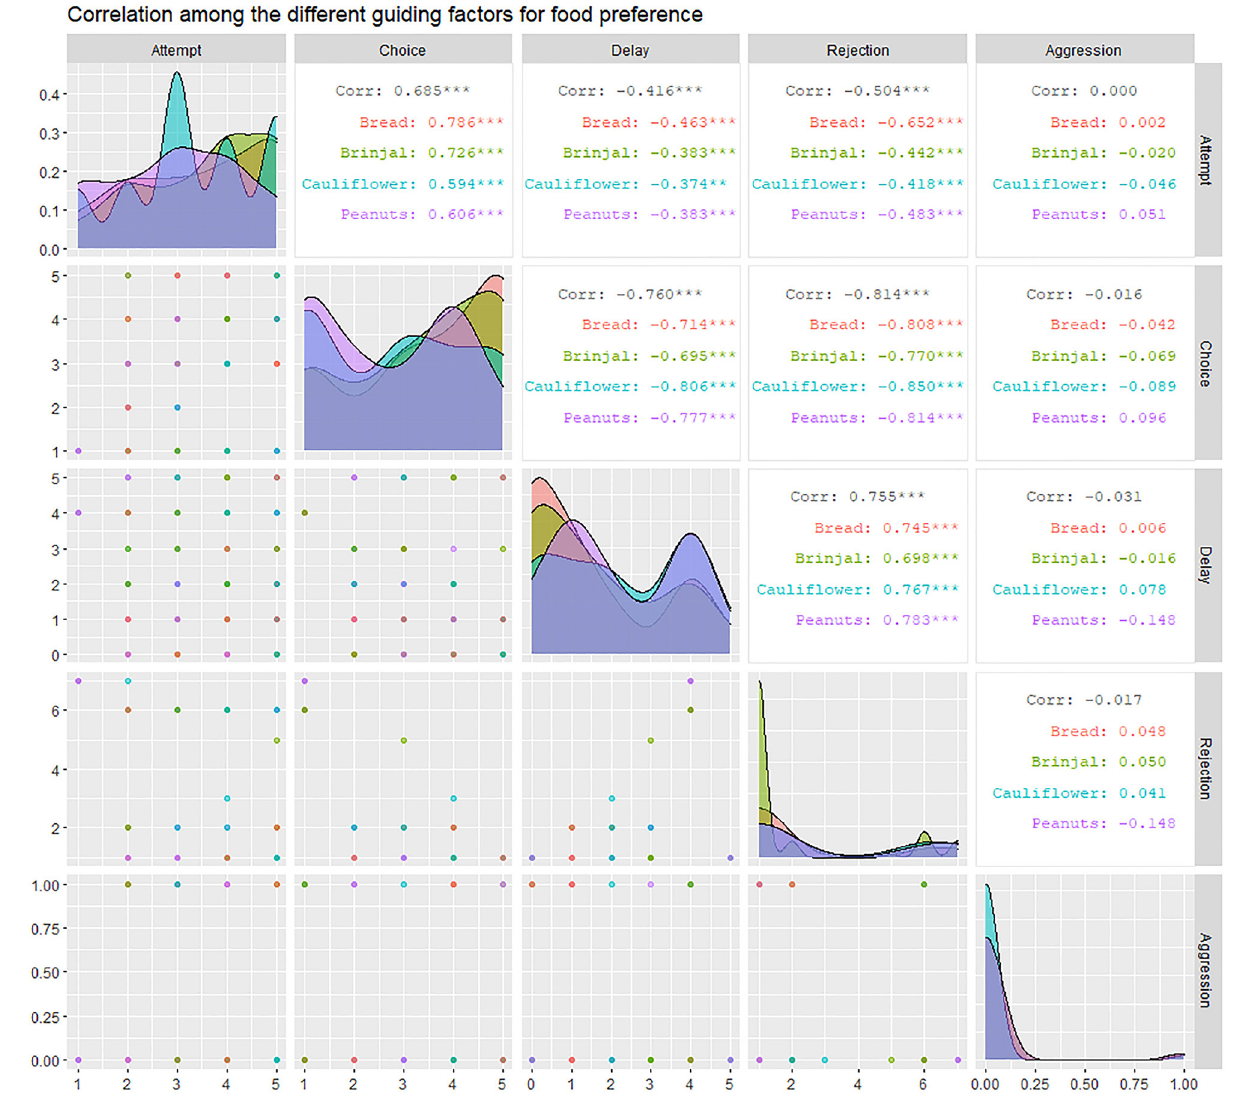
(positive) and RJ (negative) showed more significant effects